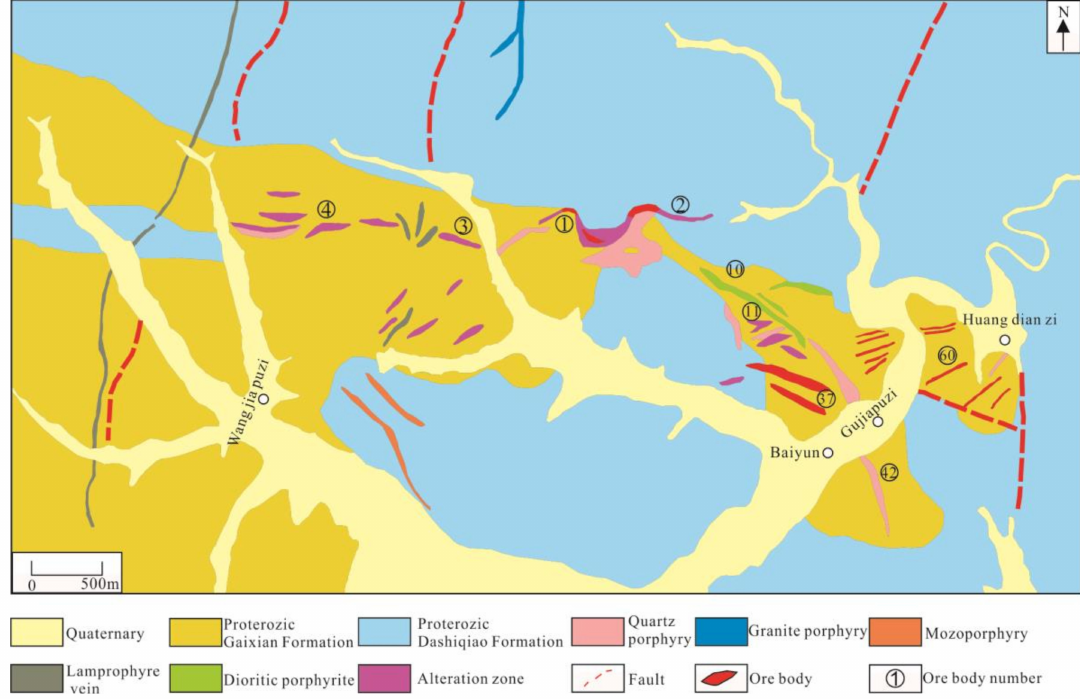
Figure 3. Geological map of the Baiyun gold deposit showing the distribution and occurrence of major gold lodes (modified from